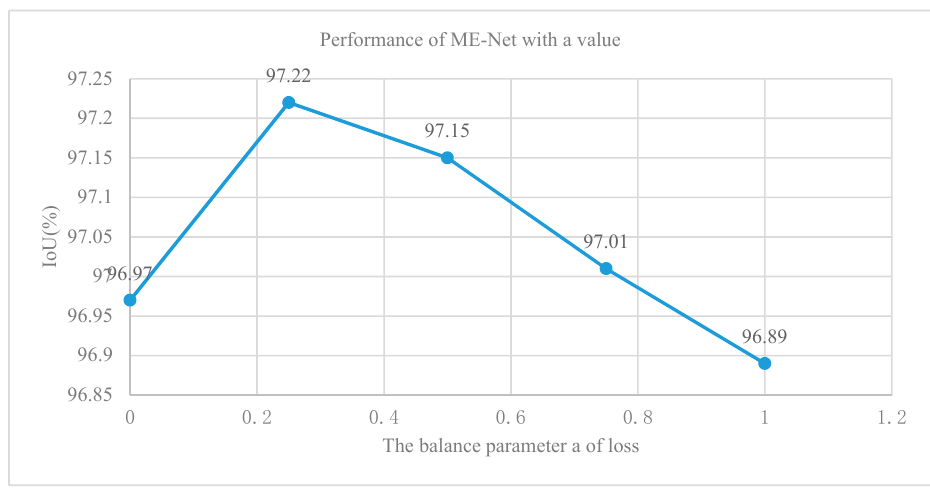
Figure 13. Results of ME-Net with different values of balance weight a.